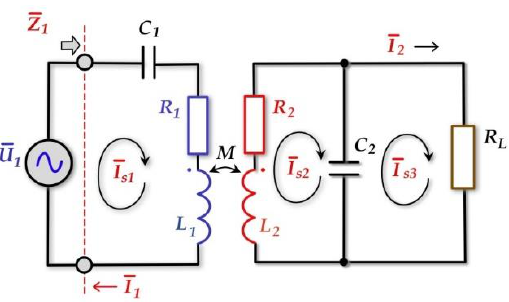
Figure 1. Principal schematic of the WPT S-P compensation equivalent circuit.